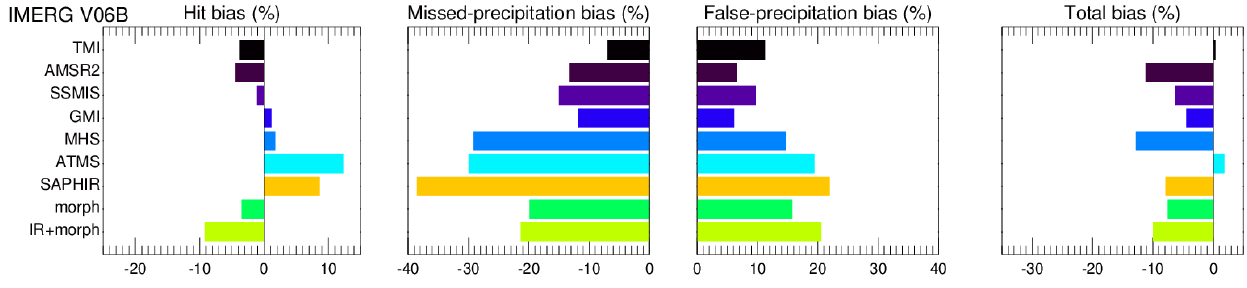
Figure 8. Same as Figure 7 but for IMERG V06B.